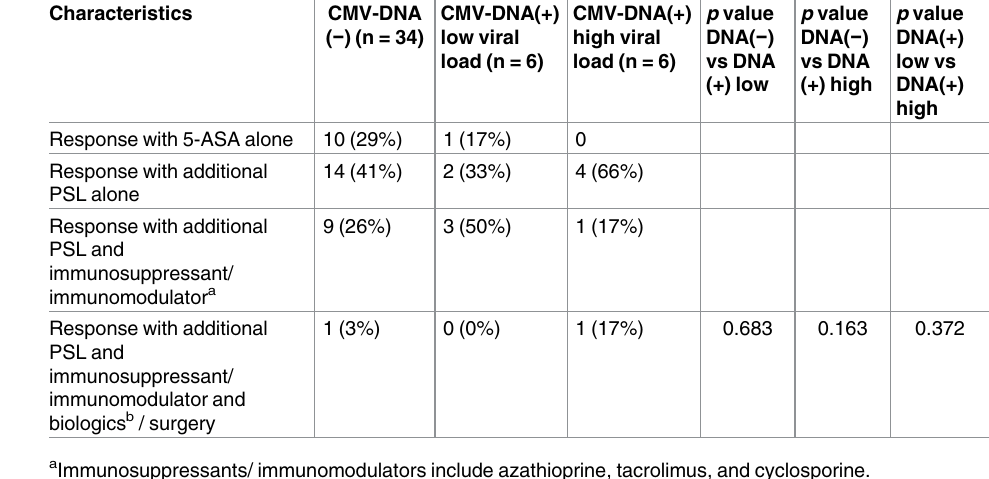
Table 3. Differencesin clinical course among CMV-DNA − patients, CMV-DNA+ patients with low viral load, and CMV-DNA+patients with high viral load (N = 46).